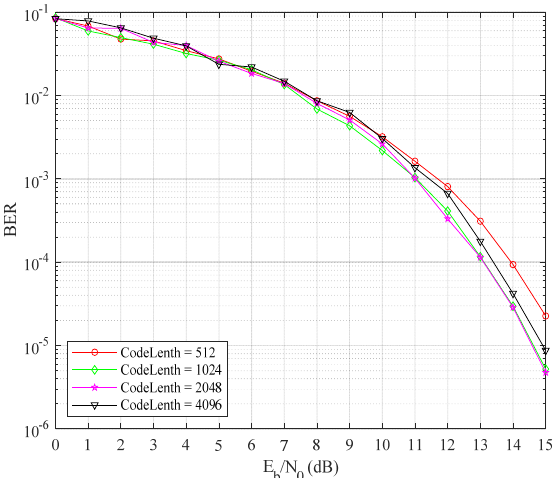
Figure 5. BER of cooperative FSO communication system with different code lengths.